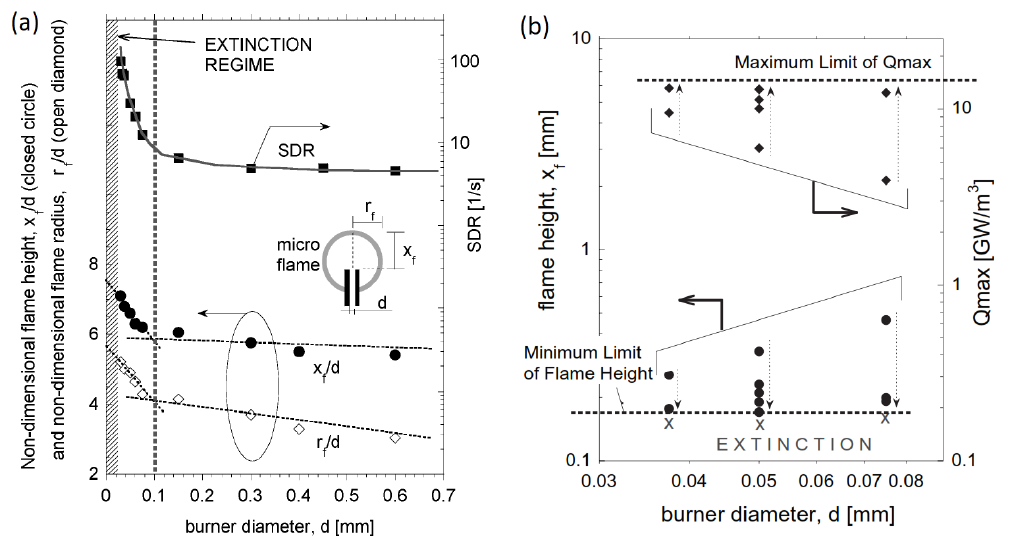
Figure 2. Numerical study of methane micro diffusion flame to analyze the burner size effects by Nakamura et al. [11]. ( a ): Size effects on flame shapes and scalar dissipation rate (SDR) evaluated at the location of maximum heat release rate; ( b ): Minimum flame height and corresponding maximum local heat release rate, Q max